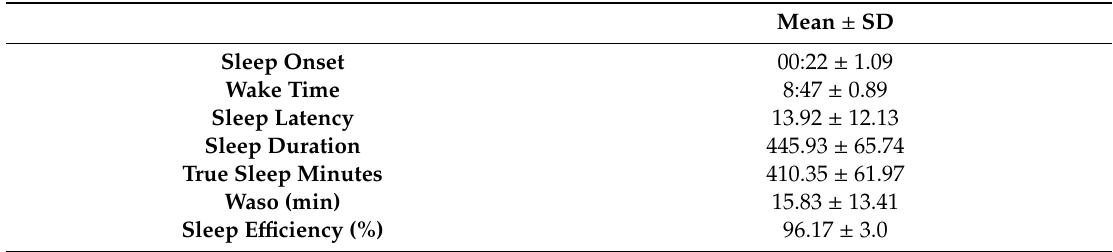
Table 1. Actigraphic sleep